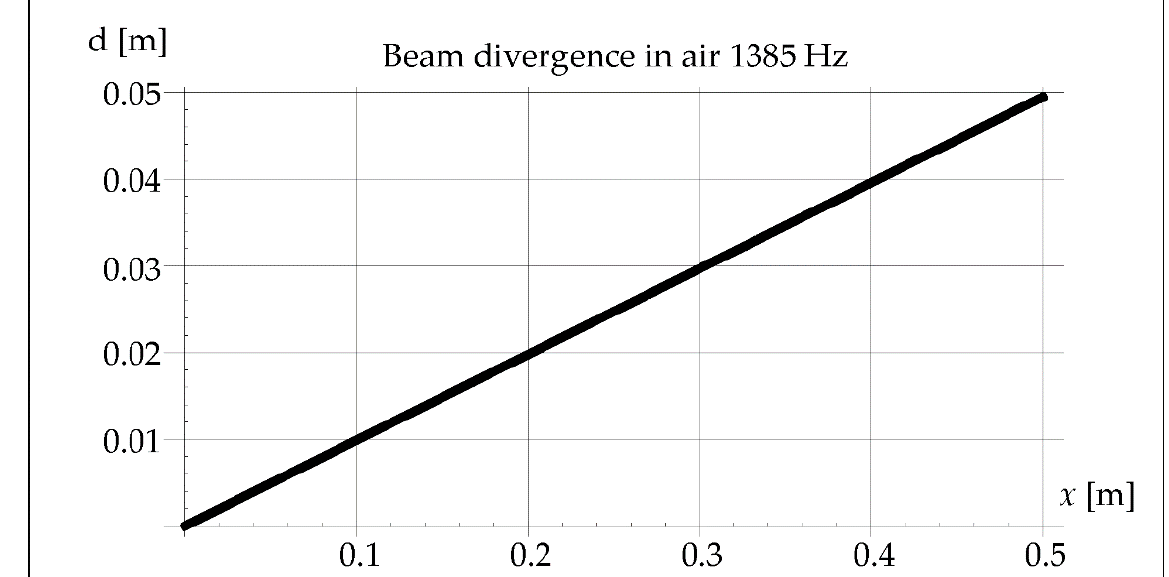
Figure 17. Beam divergence in air at 1385 Hz. In steel, the divergence of the vibration beam is shown in Figure 18.